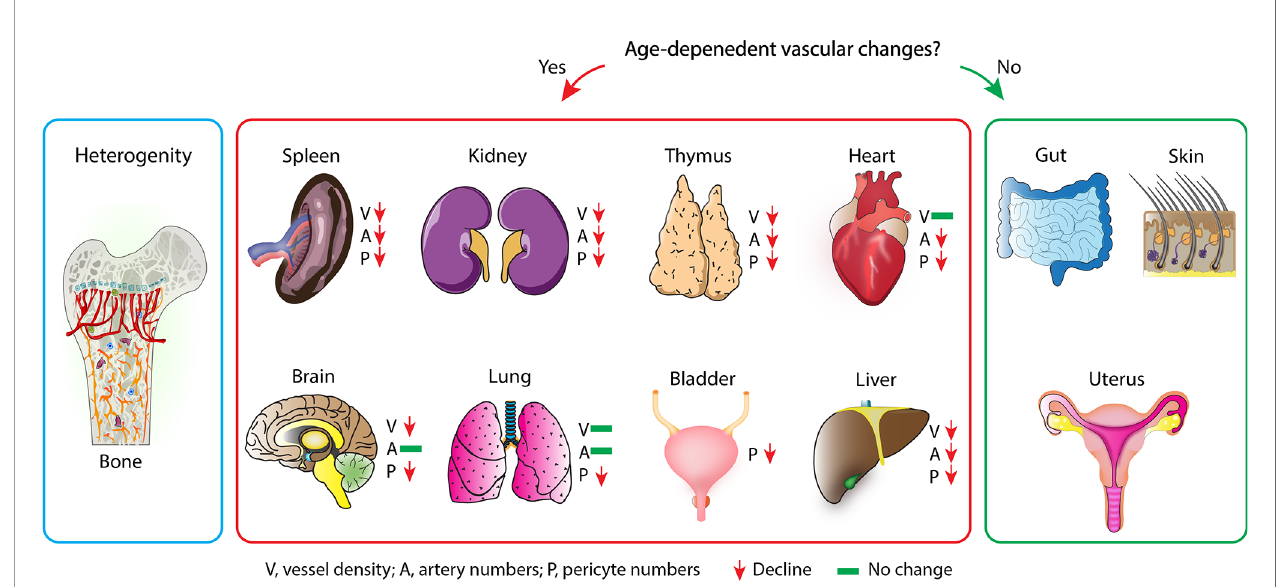
FIGURE 4 | Vascular ageing across different tissues: Vascular ageing causes the decrease in endothelial heterogeneity of the bone but not the overall vessel density. This age-dependent change of the bone marrow vasculature is hallmarked by the decrease of type-H vessels (Left). Across all organs, different vascular changes are observed during the ageing process. Decreased vessel density, artery numbers and pericytes number are observed in spleen, kidney, thymus and liver. Fewer changes are observed in heart, brain, and lung (middle). On the other hand, gut, skin, and uterus maintain their vasculature integrity during ageing